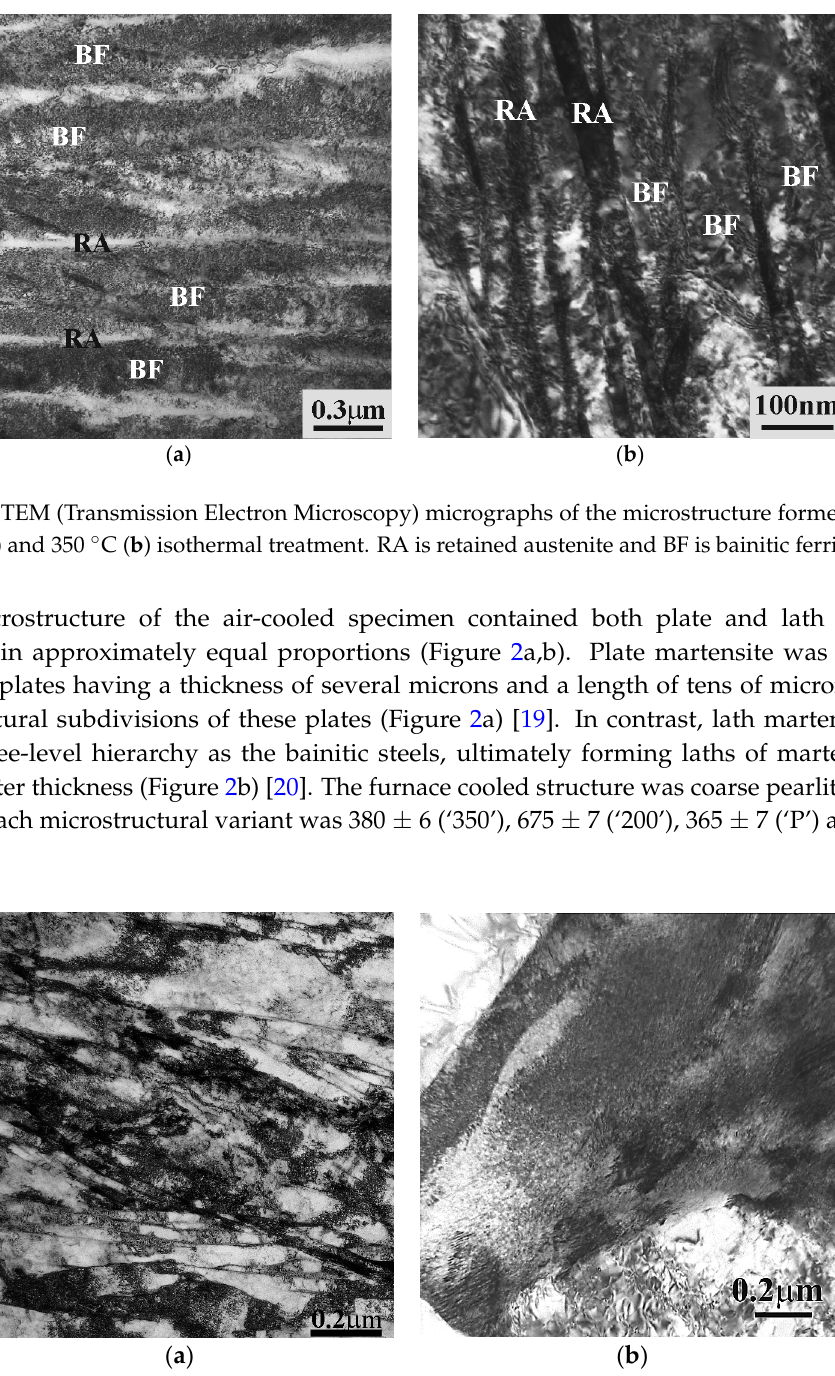
Figure 2. TEM images of plate ( a ) and lath ( b ) martensite.